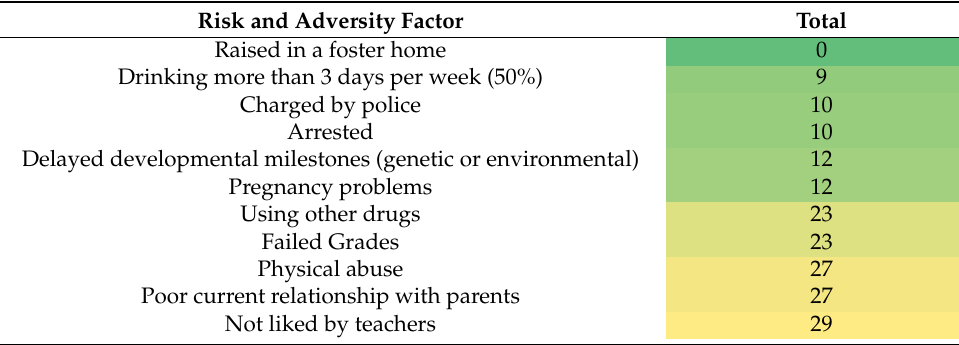
Table 2. Most Common Reported Factors Associated with ADHD in this